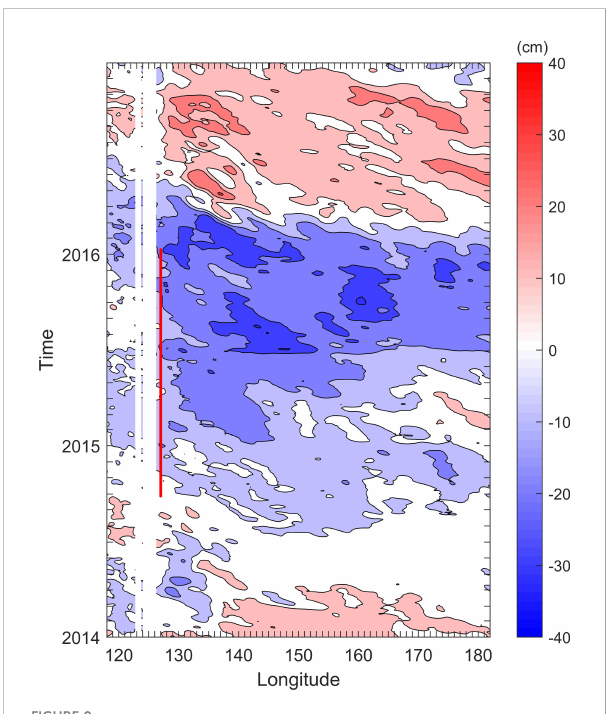
FIGURE 9 Time-longitude diagram of Sea level anomaly along 8°N from CMEMS. The red line presents the mooring current observed